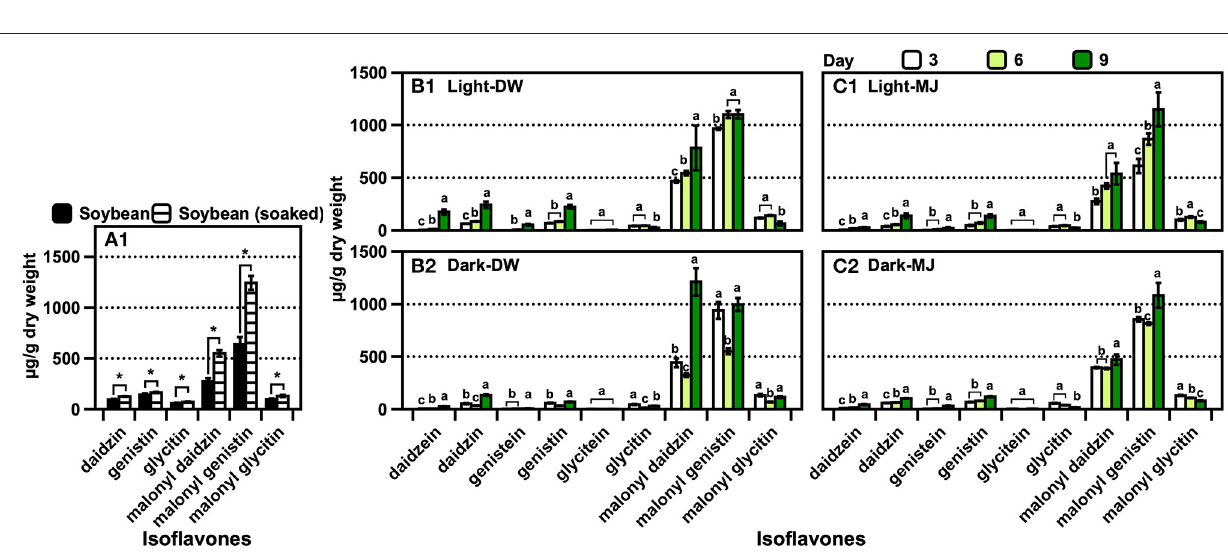
FIGURE 6 | Isoflavone contents of (A) soybean before germination, (B) soybean seedlings in water, and (C) soybean seedlings in MJ solution. The data are expressed as the mean ± standard error of the mean. Asterisk “*” on the bar indicates the significant differences of the comparisons for each pair by Student’s t -test at an α = 0.05 level. The lowercase letters on the bar in the same compounds indicate the significant differences of the comparisons for all the pairs by the Tukey–Kramer honestly significant difference test at an α = 0.05